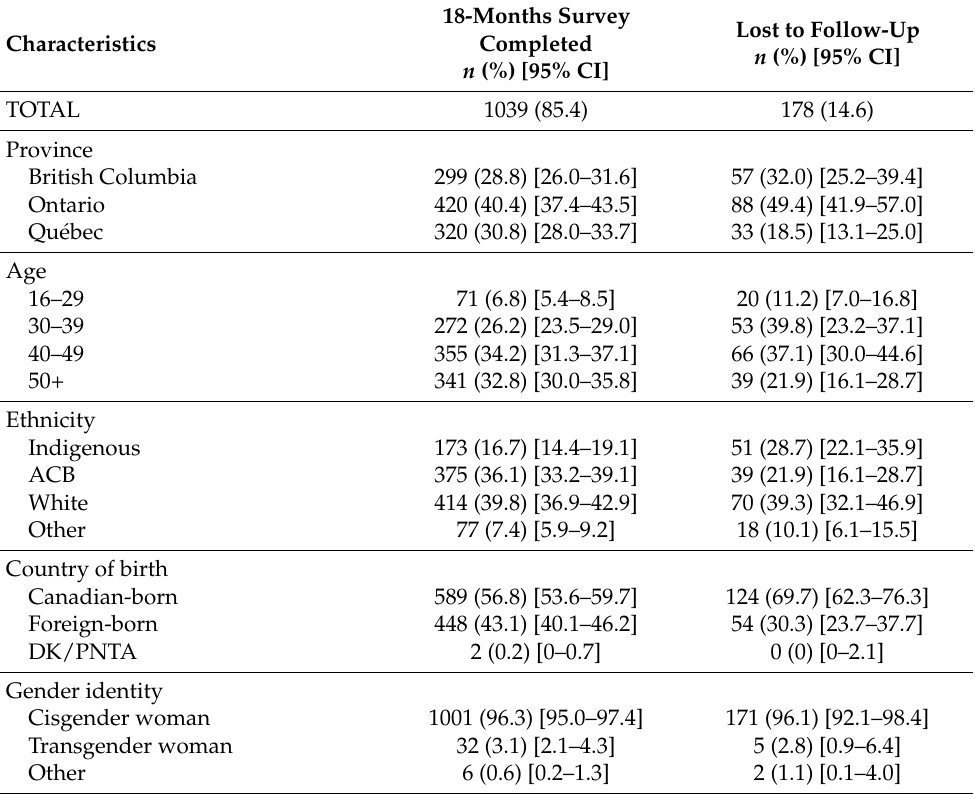
Table 1. Baseline characteristics of participants from the Canadian HIV Women’s Sexual and Repro- ductive Health Cohort Study (CHIWOS) who completed the 18-months survey compared to those who were lost to